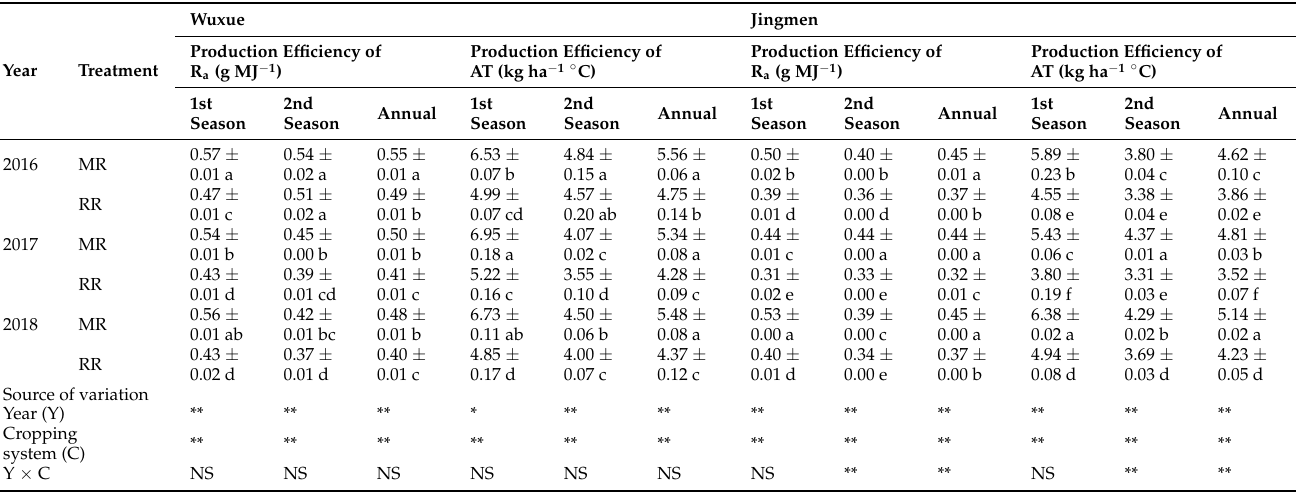
Table 8. Production efficiency of radiation and accumulated temperature in the MR and RR cropping systems from 2016 to 2018 at Wuxue and